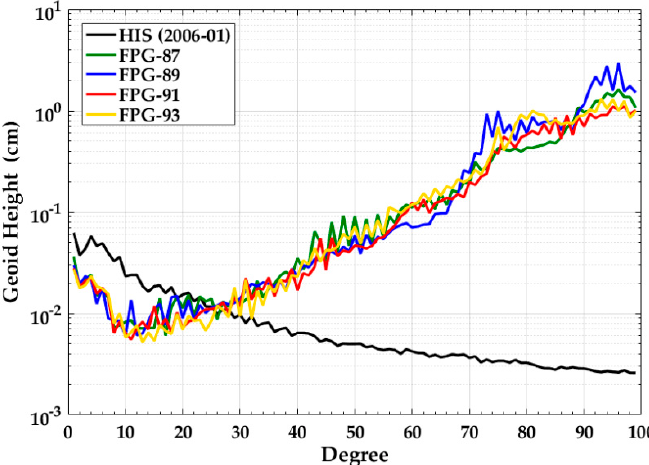
Figure 2. True HIS signal and degree geoid height errors (DGHE) of different FPG standalone models in January 2006.